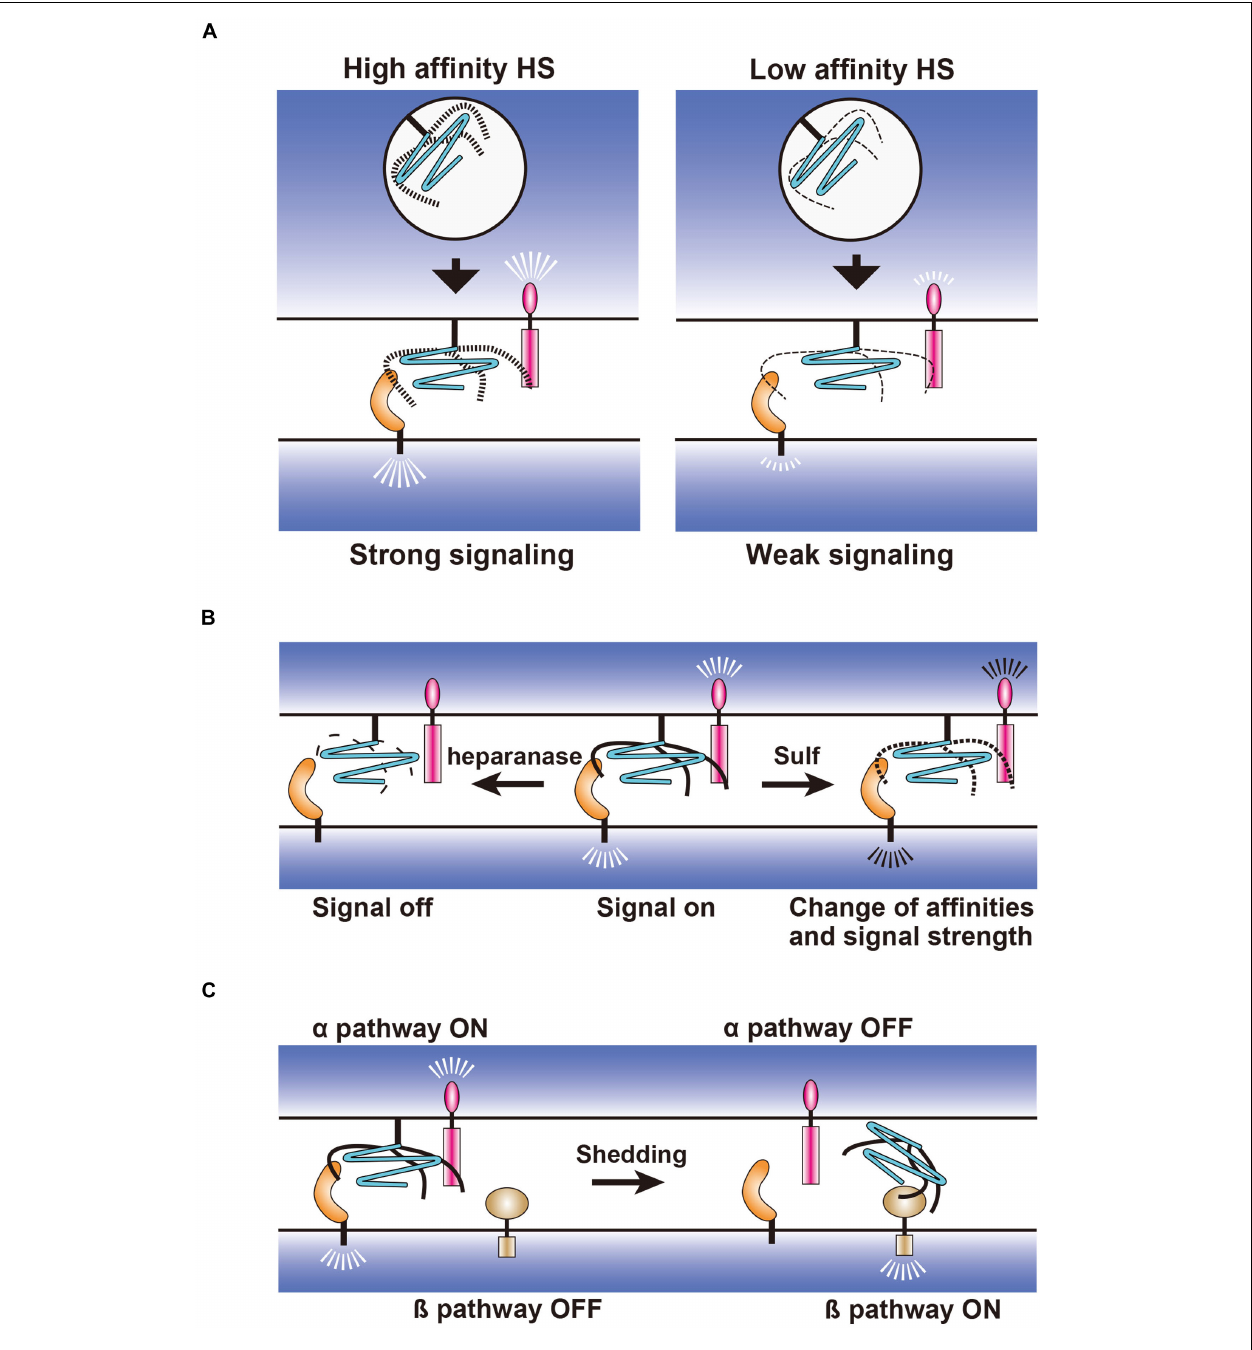
FIGURE 3 | Hypothetical models for the regulation of synapse-organizing proteins by glypicans. (A) Fine structures of HS generated during biosynthetic processes may regulate the affinity strength between the synapse-organizing proteins affecting their signal strengths. (B) Extracellular regulation of HS structures by heparanase and 6- O endosulfatase (Sulf). Fragmentation of HS by heparanase and 6- O desulfation by Sulf may turn the signal off and change the signal strength of synapse-organizing proteins, respectively. (C) Effects of the glypican shedding on the synapse-organizing proteins. Shed glypicans may not activate synapse-organizing proteins ( α pathway), but instead activate an alternative signaling pathway ( β pathway).